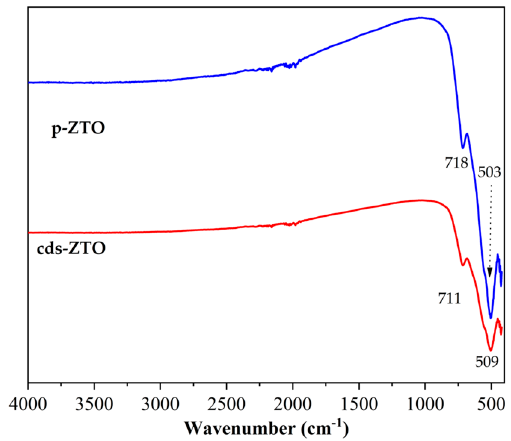
Figure 7. Fourier transform infrared spectra (FT-IR) of cds-ZTO ( bottom ) and p-ZTO ( top ).